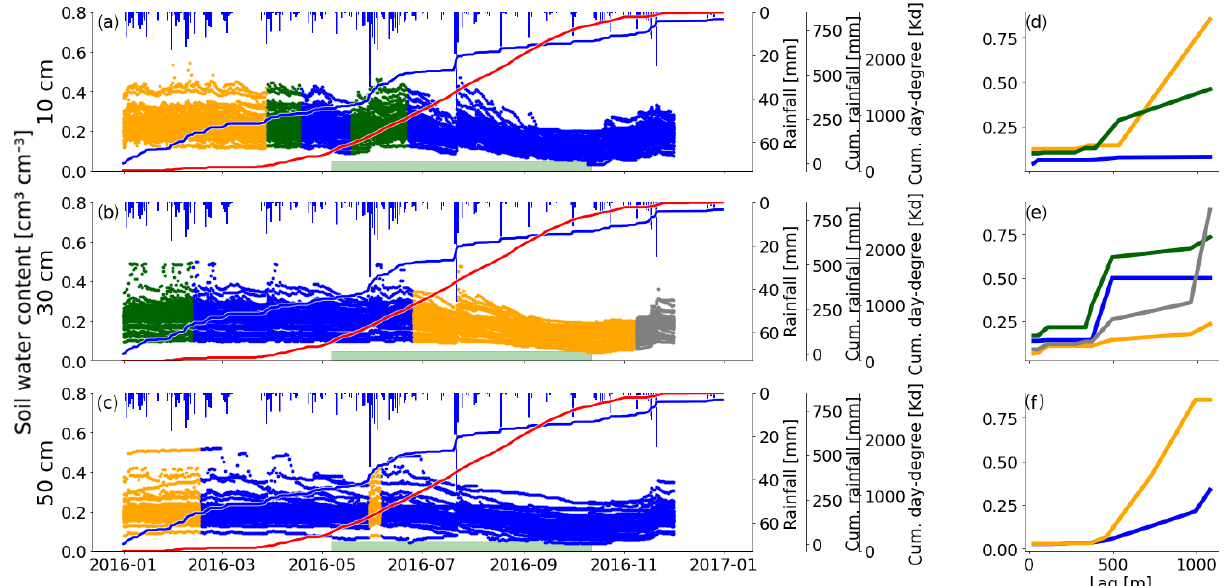
Figure 4. Soil moisture time series of 2016 in all three depths with respective cluster centroids. The three rows show the data from 10cm (a) , 30cm (b) and 50cm (c) . The colors indicate the cluster membership of the corresponding dispersion function of the respective window position. The green bar marks the assumed vegetation period. It covers the dates where the cumulative day-degree sum is > 15% and < 90% of the maximum. The cluster centroids for each depth are shown in (d–f)